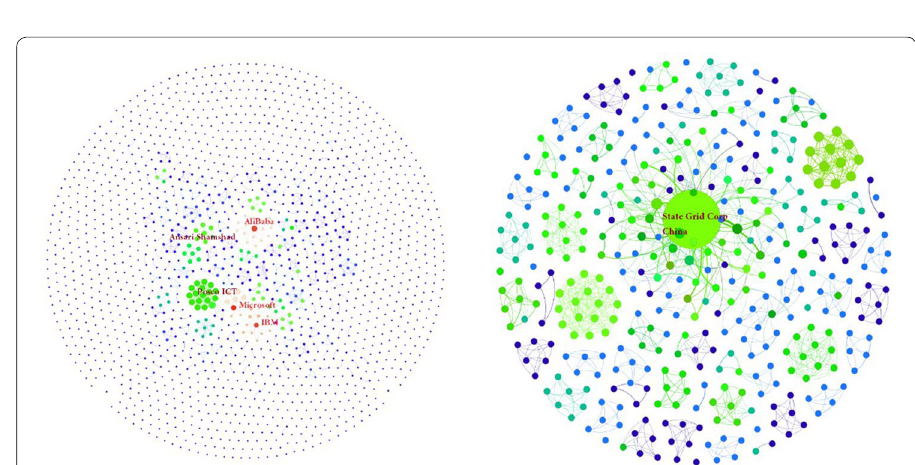
Fig. 13 Another portray of the network of co-applicants, the right is all applicants from all jurisdictions, and the left one is composed only of Japan, US, Germany, European patents, Republic of Korea, WIPO, UK, France and